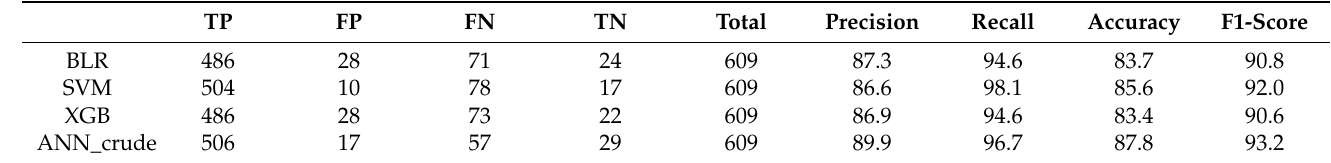
Table 2. Results of several performance parameters of machine learning algorithms to predict hemorrhagic transformation in the test